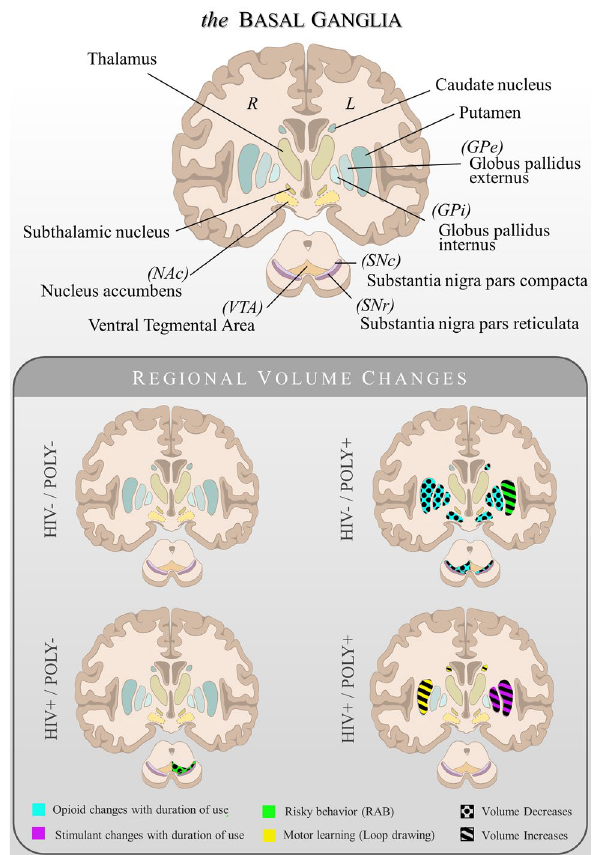
Figure 2. Summary of gray matter volume changes within the basal ganglia for each study group . Top: A coronal view schematic of the regions of interest examined within the basal ganglia and midbrain. L = left; R = right. Bottom: Colored regions indicate the locations within the basal ganglia that were associated with duration of substance use, motor learning, and risky behaviors. Patterns indicate the positive or negative direction of the association. Depictions may be compared with Fig. 3 and Table